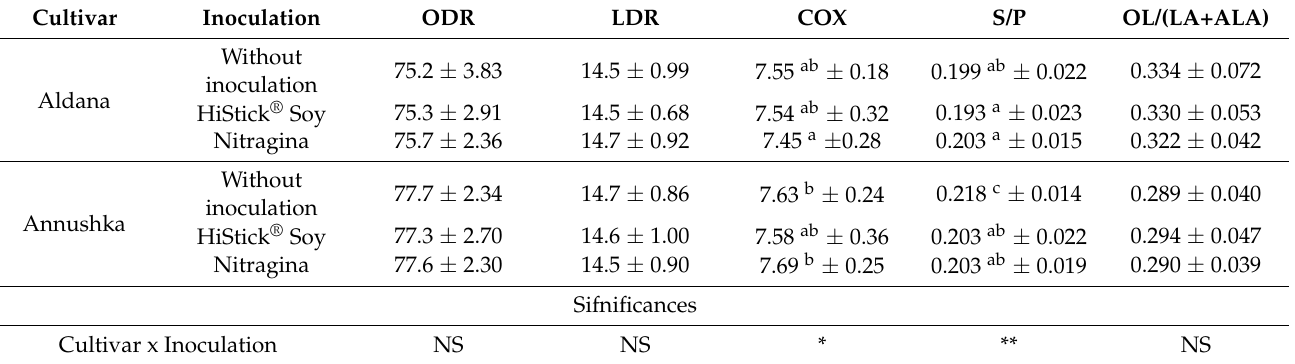
Figure 2. Value of the saturation fat index (S/P), mean values for interaction inoculation × years. Mean values ± SD. Means followed by different letters show significant differences ( p < 0.05) accord- ing to the post-hoc Tukey test. Differences significant at: * p < 0.05.